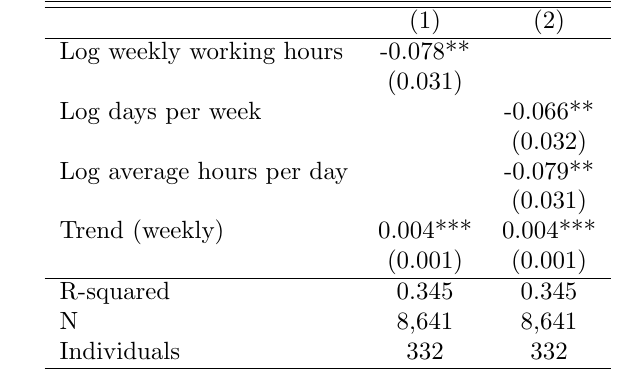
Table 4: Relationship between productivity and working time at the week level